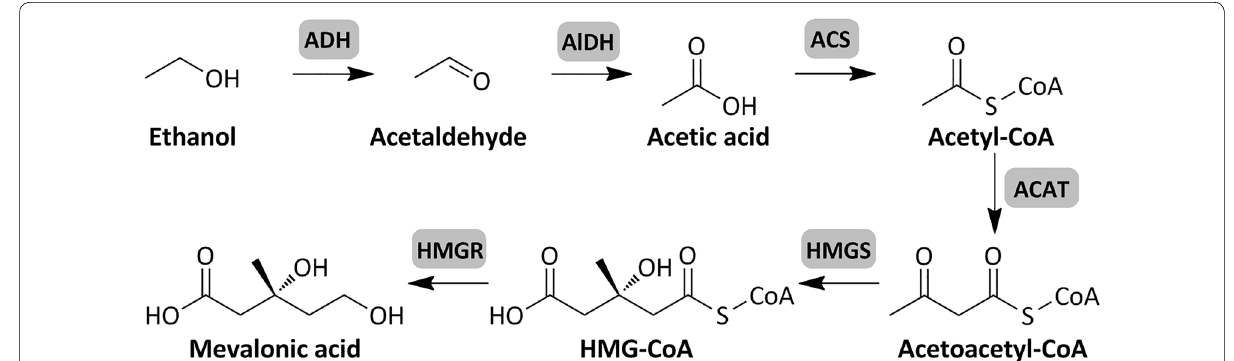
Fig. 1 Metabolic pathway for ethanol utilization and mevalonic acid production. Enzymes involved in the pathway include: ADH alcohol dehydrogenase, ALDH aldehyde dehydrogenase, ACS acetyl-CoA synthetase, ACAT acetyl-CoA acetyltransferase, HMGS HMG-CoA (3-hydroxy-3-methylglutaryl CoA) synthase, HMGR HMG-CoA